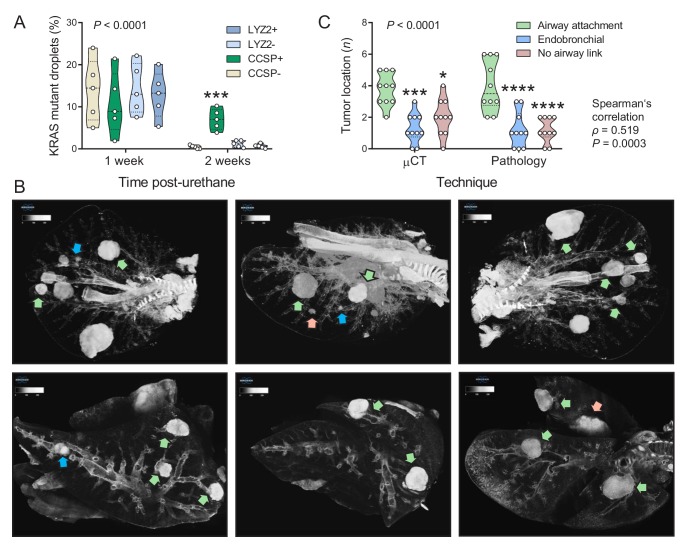
Airway cells sustain KrasQ61R mutations inflicted by urethane and give rise to juxtabronchial lung adenocarcinomas.(A) DNA was extracted from the lungs of GFP;CCSP.CRE and GFP;LYZ2.CRE mice (FVB strain) one and two weeks post-urethane treatment (n = 5/group). Summary of duplexed digital droplet PCR (ddPCR) results using primers and probes specific for the RosamT and the KrasWT sequences. Note that all cell types equally suffer initial KrasQ61R mutations, but only GFP-labeled cells of GFP;CCSP.CRE mice (i.e. airway cells) maintain the KrasQ61R mutation after two weeks. See also Figure 2—figure supplement 1. Data are shown as violin plot. P, overall probability, two-way ANOVA. ***: p<0.001 compared with all other groups, Bonferroni post-tests. (B) Representative high-resolution micro-computed tomography (μCT) lung sections (top) and three-dimensional reconstructions (bottom) from urethane-treated FVB mice six months after treatment (n = 10). Note lung tumors attached to (green arrows) or contained within (blue arrows) the airways, as well as lung tumors with no obvious link to a bronchus (red arrows). (C) Summary of results from μCT (data from Figure 2B) and pathology (data from Figure 1C) shown as violin plot. P, probability, two-way ANOVA.*, ***, and ****: p<0.05, p<0.001, and p<0.0001, respectively, compared with airway-attached tumors, Bonferroni post-tests. Shown are also Spearman’s correlation coefficient (ρ) and probability (P) for correlation of μCT and pathology results.10.7554/eLife.45571.031Figure 2—source data 1.Quantification ofKrasmutant droplets in duplexed digital droplet PCR (ddPCR).10.7554/eLife.45571.032Figure 2—source data 2.Quantification of tumor airway link.